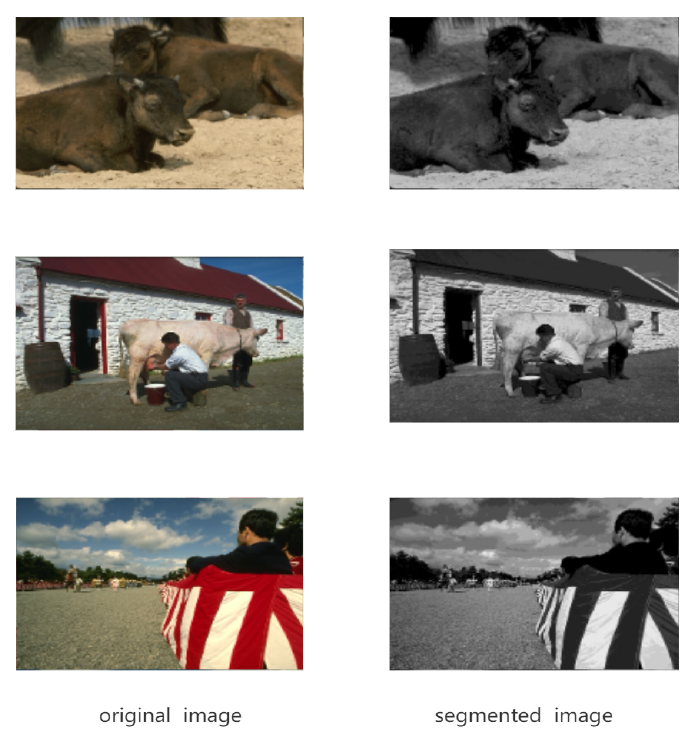
Figure 4. Group2: Original Images and Segmented Images on D =